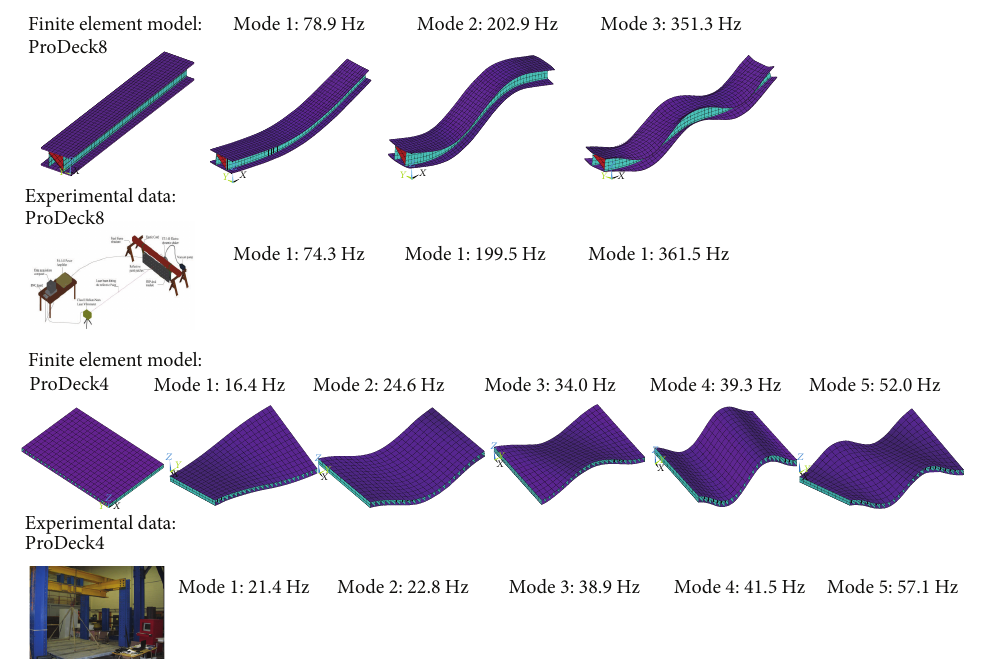
Figure 7: Frequencies and mode shapes of FRP composite